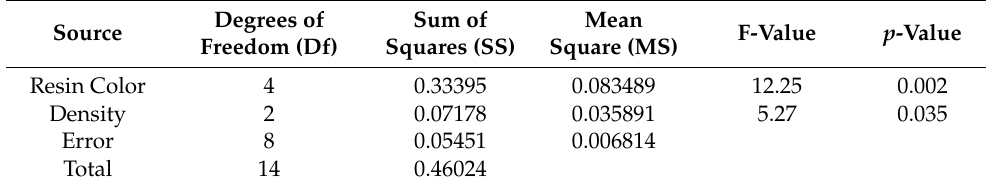
Table 7. Analysis of variance for